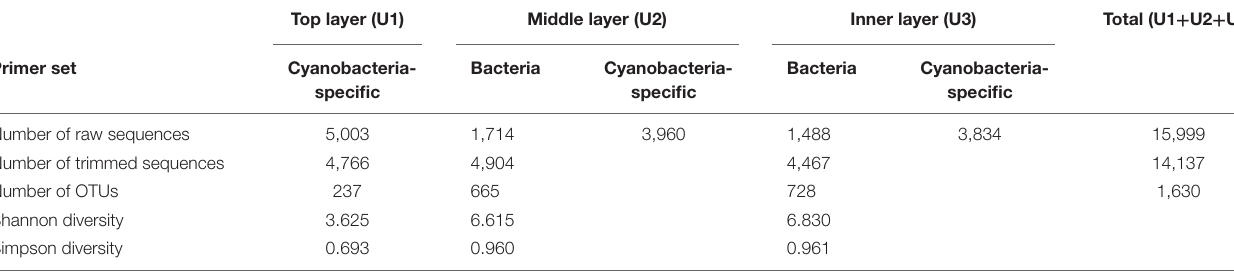
TABLE 1 | Raw and trimmed sequence reads following tag-encoded FLX amplicon pyrosequencing.